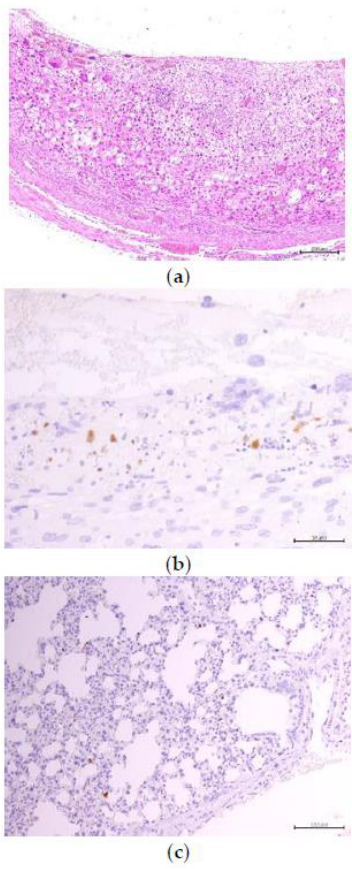
Figure 5. Placentas of hamsters in group 2 revealed coagulation in the maternal spaces and stromal decidual cells in the decidua capsularis ( a ). The virus antigen was detected in mononuclear leukocytes in areas of necrosis in the decidua capsularis ( b ), and a few alveolar macrophages ( c ) were stained positive in dam no. 3. IHC, polymer horseradish peroxidase technique, Mayer’s hematoxylin counterstain.